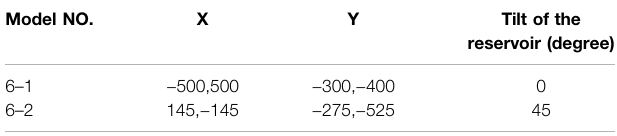
TABLE 9 | The model parameters of various vertical distribution combination models of hydrate reservoirs that need to be compared in this group. Model NO.